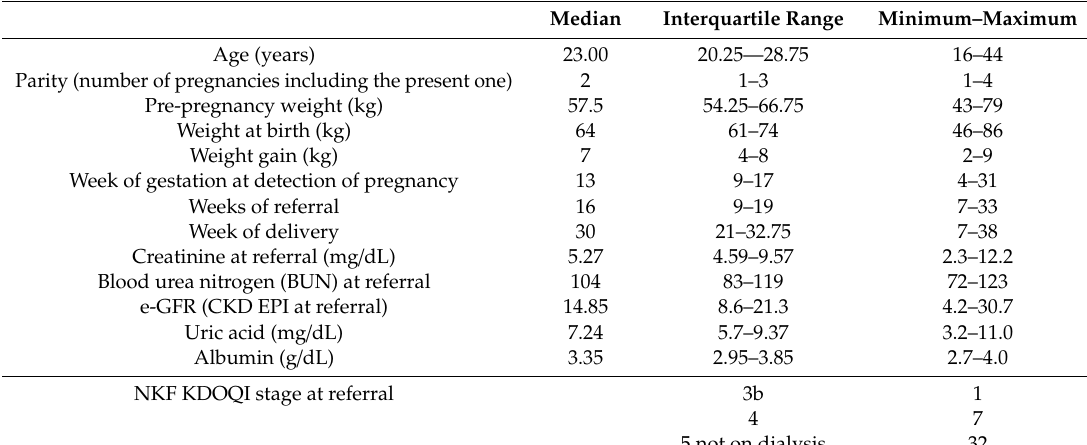
Table 1. Baseline characteristics of the patients: data at